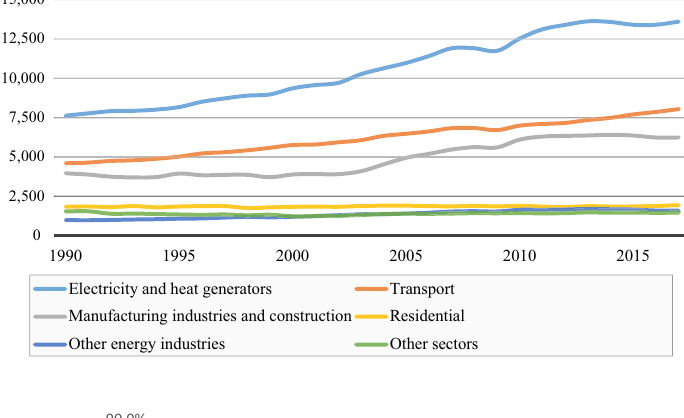
Figure 1. CO2 emissions (Million Tonnes)